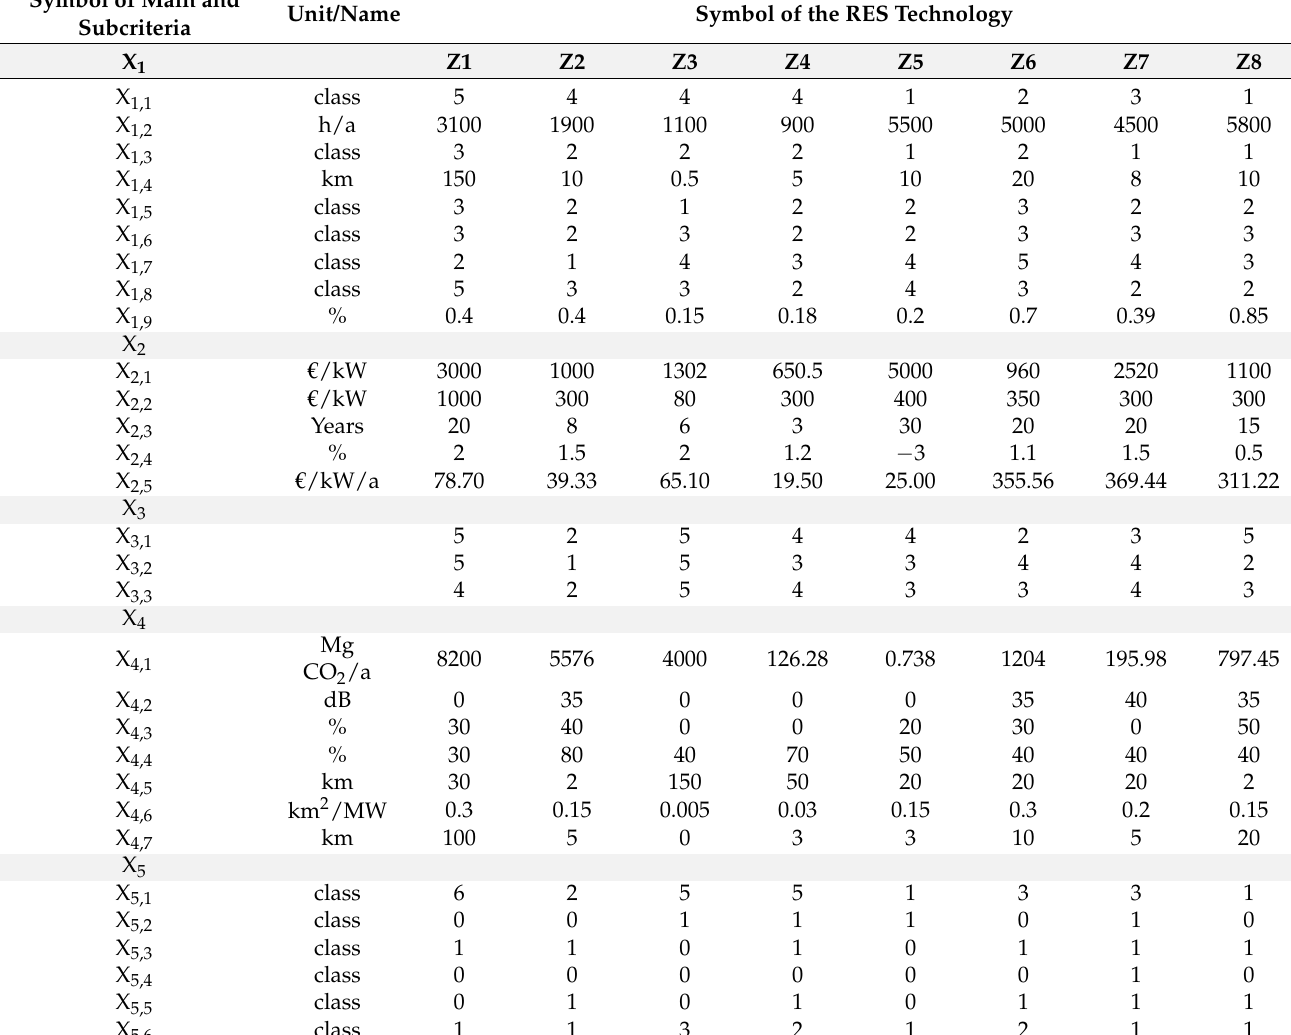
Table 4. The assumptions for the comparative analysis of RES